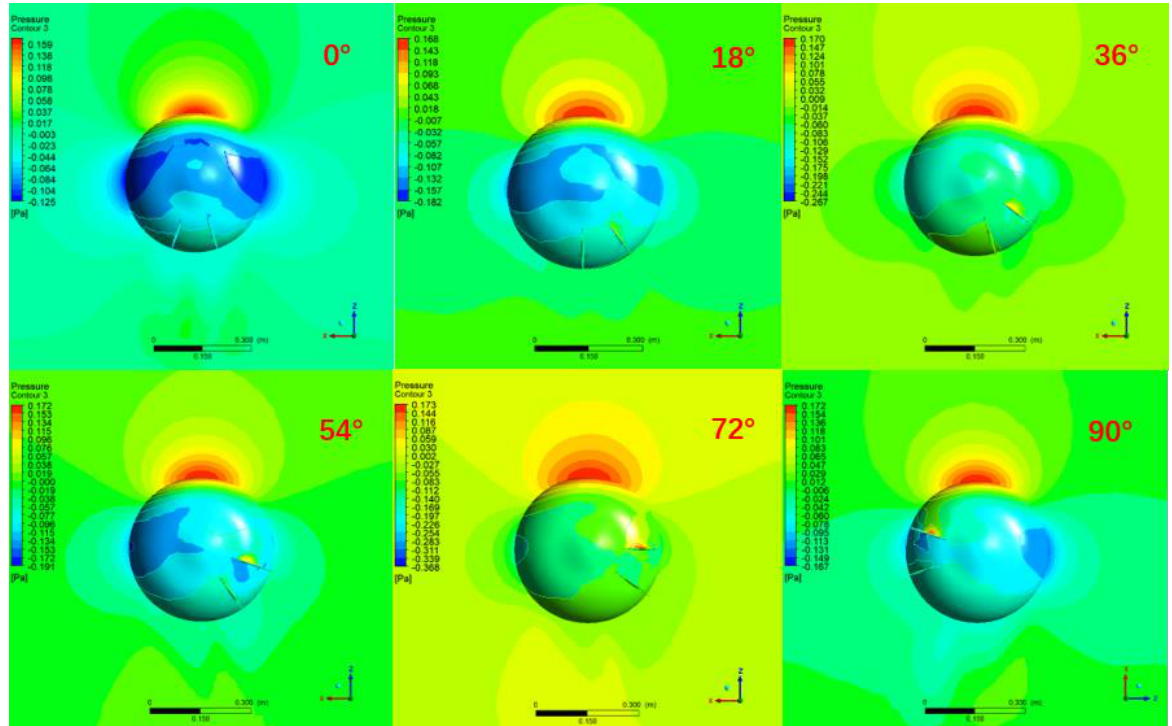
Figure 2. Pressure contour in the horizontal plane of the shell with fins at different angles. As the angle is rotated, the pressure around the shell gradually increases and reaches a maximum at 72 degrees.